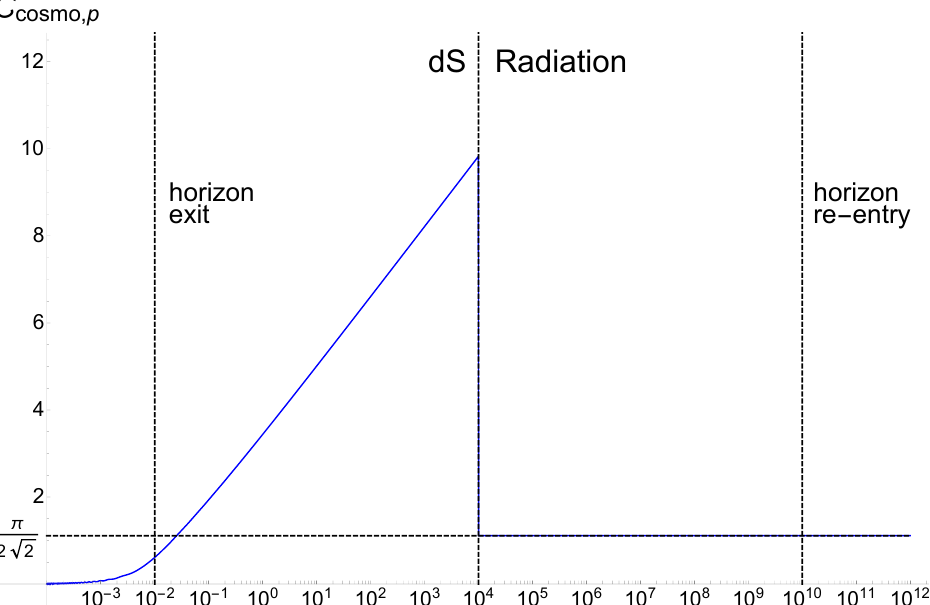
Figure 9. The complexity for cosmological perturbations with an alternative model of decoherence in which the perturbations evolve into the mixed state (3.30) at the transition between the de Sitter and radiation phases. The complexity jumps discontinuously to the saturated value C cosmo , p ≈ √ π/ (2 2) at the moment of